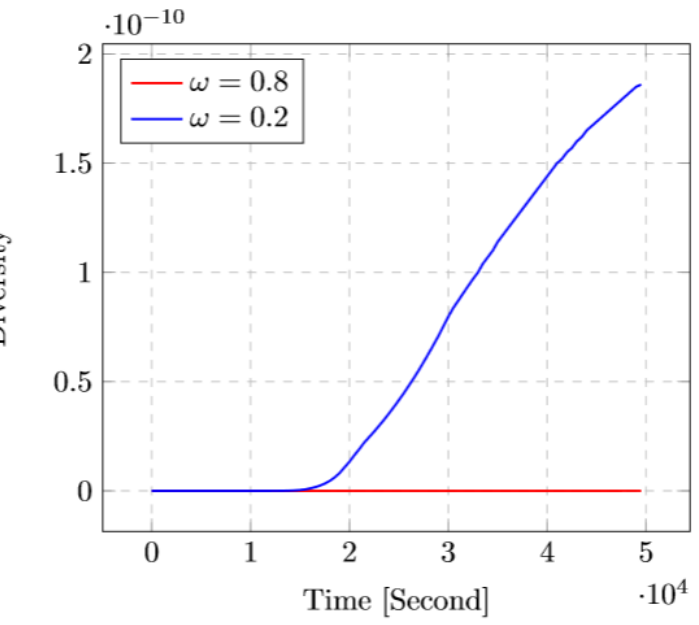
Figure A5. Diversity for an alternative environment, namely with ω = 0.8 and ω = 0.2 and 20 sensors.